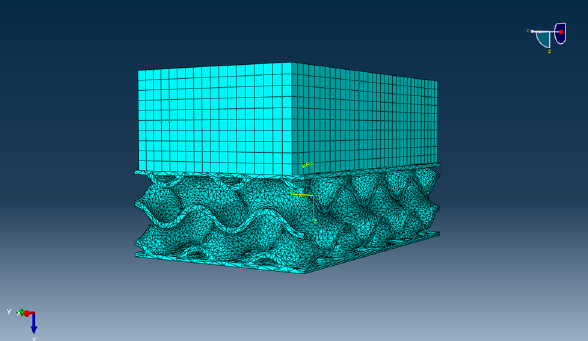
Figure 17. Finite element model setup of the modal analysis in Abaqus software.